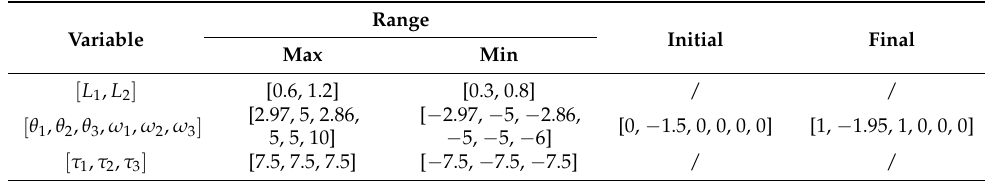
Table 5. The information of the design, state, and control variable of test